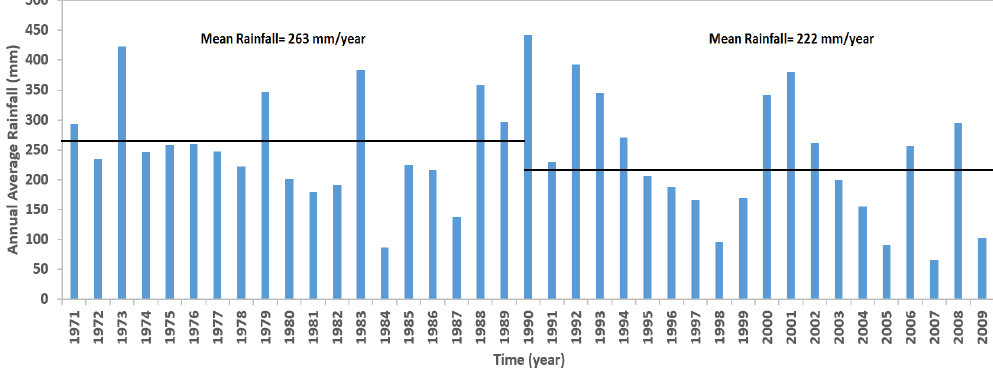
Figure 7. Comparison of mean annual rainfall for the periods 1971–1990 and